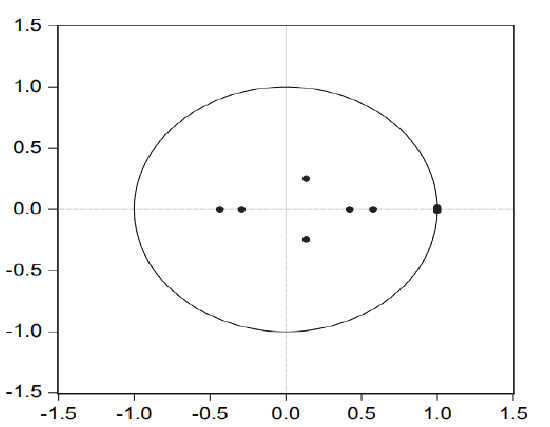
Figure 1. The inverse roots of the AR characteristic